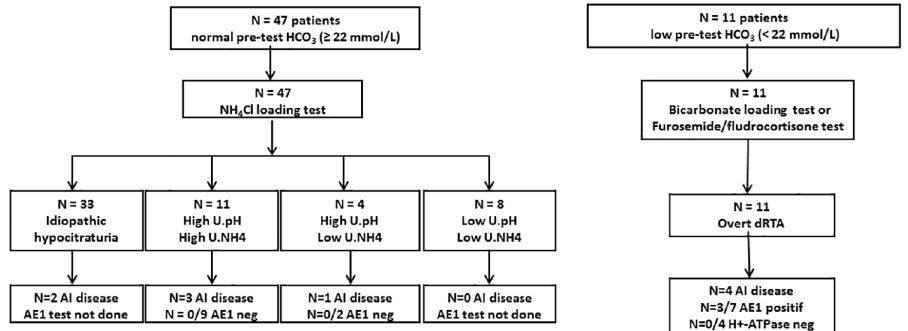
Fig 3. Study results flow chart. Subgroupsclassifications: idiopathic hypocitraturia : min. urine pH < 5.3, max. NH 4+ (cid:21) 33 μ Eq/min.; high U. pH, high U. NH 4 : min. urine pH (cid:21) 5.3, max. NH 4+ (cid:21) 33 μ mol/min.; high U. pH, low U. NH 4 : min. urine pH (cid:21) 5.3, max. NH 4+ < 33 μ Eq/min.; low U. pH, low U. NH 4 : min. urine pH < 5.3, max. NH 4+ < 33 μ Eq/min. AE1: chloridebicarbonate exchanger; AI: autoimmunedisease;E161K: missense polymorphism (p.Glu161Lys) of the ATP6V1B1 gene; H+-ATPase: B1 and a4-subunitsof the apical H +-ATPase, including missense polymorphism (p.Glu161Lys) of the ATP6V1B1 gene; HCO3-: